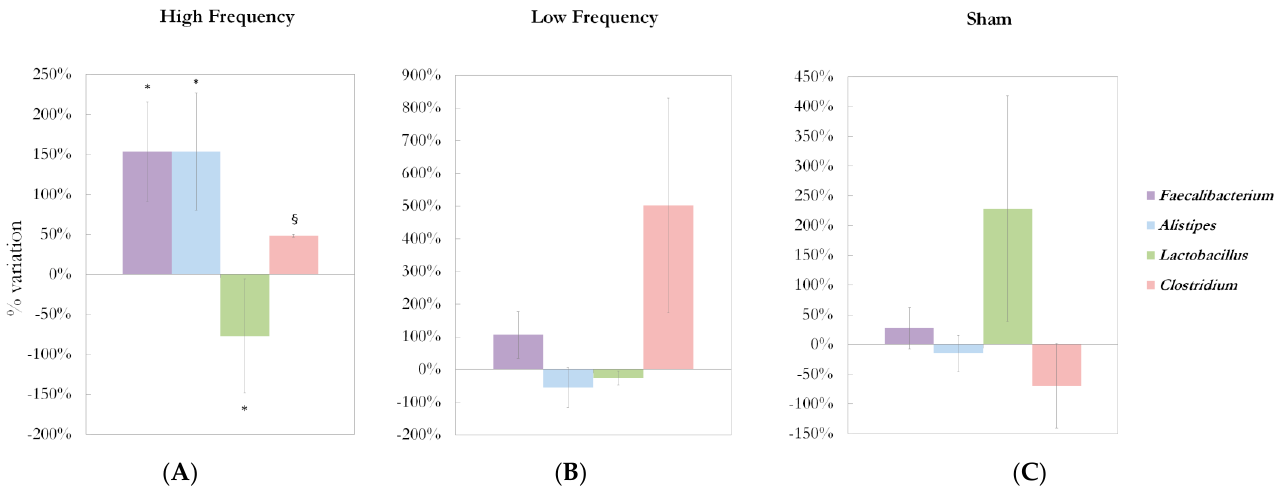
Figure 2. Deep TMS effects on gut microbiota composition in the three treatment groups. ( A ) Treatment effects on Faecalibacterium, Alistipes, Lactobacillus, Clostridium genera abundances in HF group. Faecalibacterium, Alistipes, Lactobacillus, Clostridium abundance percent change from baseline to 5-week treatment are shown (mean% ± SEM). Analysis revealed a significant increase in Faecalibacterium (reads abundance: 3105.4 ± 1425.5 vs. 7897.3 ± 2314.3, +154.3%, * p = 0.013) and Alistipes (reads abundance: 1490.7 ± 656.7 vs. 3777.8 ± 1137.8, +153.4%, * p = 0.033 vs. baseline; * p = 0.039 vs. sham; * p = 0.029 vs. LF), a significant decrease in Lactobacillus (reads abundance: 260.1 ± 115.8 vs. 59.7 ± 33.1, − 77.1%, * p = 0.013 vs. baseline; * p = 0.011 vs. sham), and a trend to increase in Clostridium (reads abundance: 1720.0 ± 806.8 vs. 2547.2 ± 822.1, +48.1%, § p = 0.058 vs. baseline; § p = 0.088 vs. sham) after 5 weeks of HF dTMS treatment. ( B ) Treatment effects on Faecalibacterium, Alistipes, Lactobacillus, Clostridium genera abundance in LF group. Faecalibacterium, Alistipes, Lactobacillus, Clostridium abundance percent variation between baseline and after the 5-week treatment is shown for low frequency (LF, 1 Hz) group. No significant variations were found in Faecalibacterium, Alistipes, Lactobacillus, Clostridium abundance in the LF group. ( C ) Treatment effects on Faecalibacterium, Alistipes, Lactobacillus, Clostridium genera abundance in the sham group. Faecalibac- terium, Alistipes, Lactobacillus, Clostridium abundance percent variation between baseline and after the 5-week treatment is shown for the sham group. No significant variations were found in Faecalibacterium, Alistipes, Lactobacillus, Clostridium abundance in the sham group. Statistical analysis was performed using the two-tailed t-test. Legend: SEM = standard error of the mean; * p < 0.05; § 0.05 ≤ p <